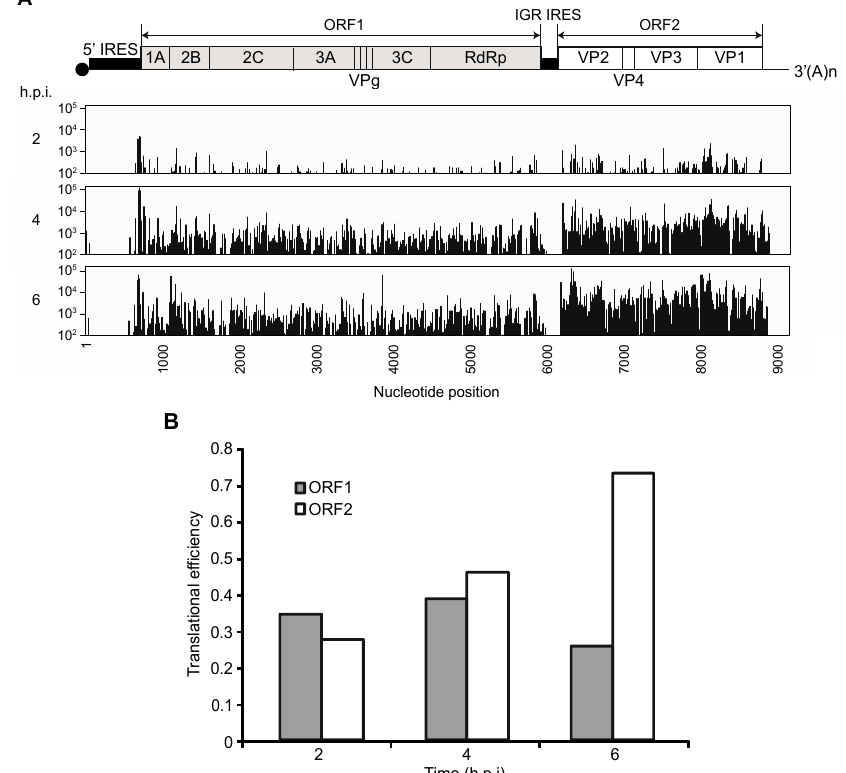
Figure 2. Ribosome profiling of the CrPV RNA in infected S2 cells. ( A ) CrPV RNA sequence coverage ( x -axis) in rpM from the ribosome-associated fractions ( y -axis) at two, four and six h.p.i (MOI 10). The coverage, as indicated, is aligned to the viral genome shown above; ( B ) Translational efficiency was calculated by dividing reads per million values for the ribosome protected fragments (RPF) by the Whole Transcriptome set (WT). The TE was determined from the average of two independent